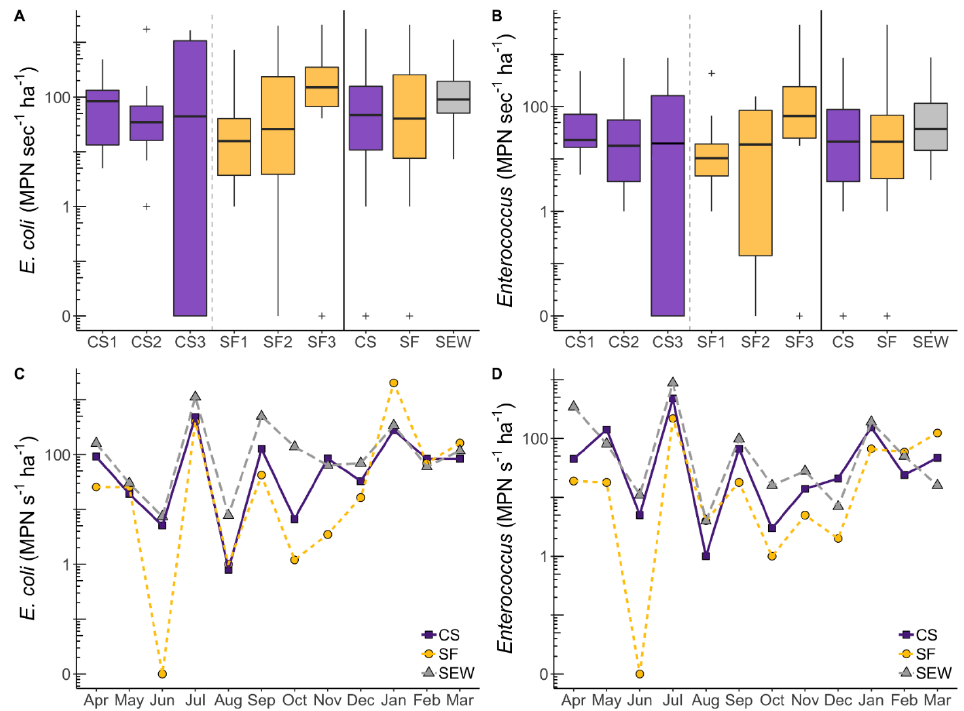
Figure 4. Boxplots ( A , B ) and time series plots ( C , D ) of area-normalized watershed exports of E. coli and Enterococcus spp. Time series plots illustrate median exports of bacterial loadings. Data ranged from April 2015 to March 2016. During summer months, flow occasionally ceased, resulting in no transport of bacteria. The plus symbol (+) denotes outliers.